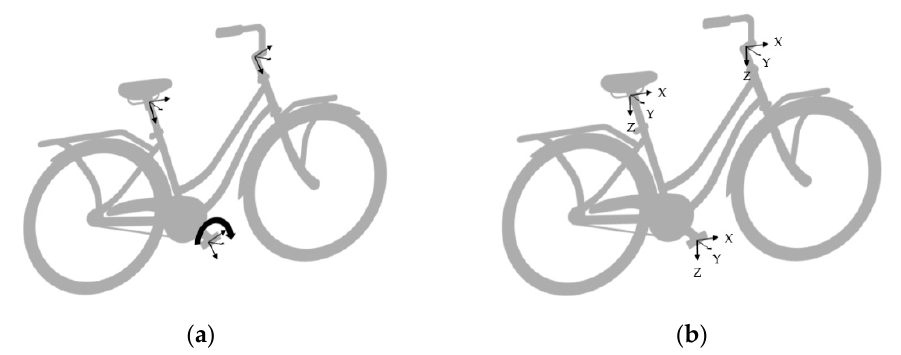
Figure 4. Transformation of local reference frames ( a ) to a global reference frame ( b ).